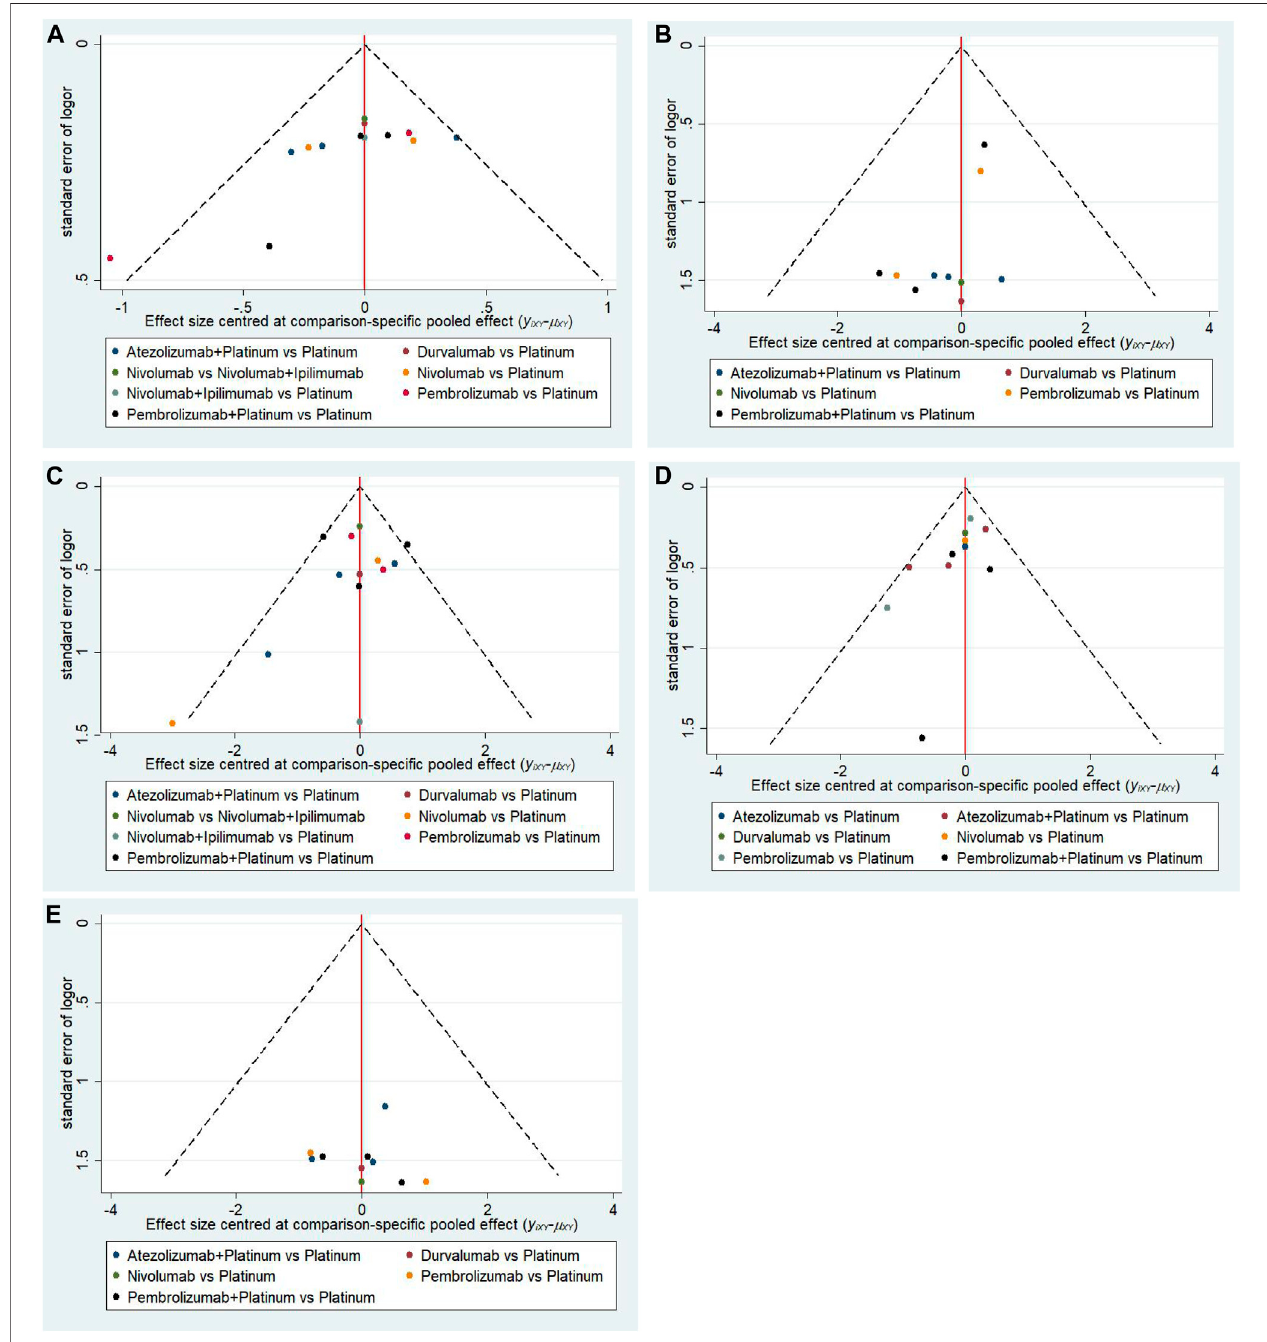
FIGURE 6 | Funnel plot of (A) dermatologic irAEs, (B) colitis, (C) endocrine irAEs, (D) pneumonitis and (E) hepatitis in the network meta-analysis.(Platinum (cid:1) Platinum based chemotherapy).